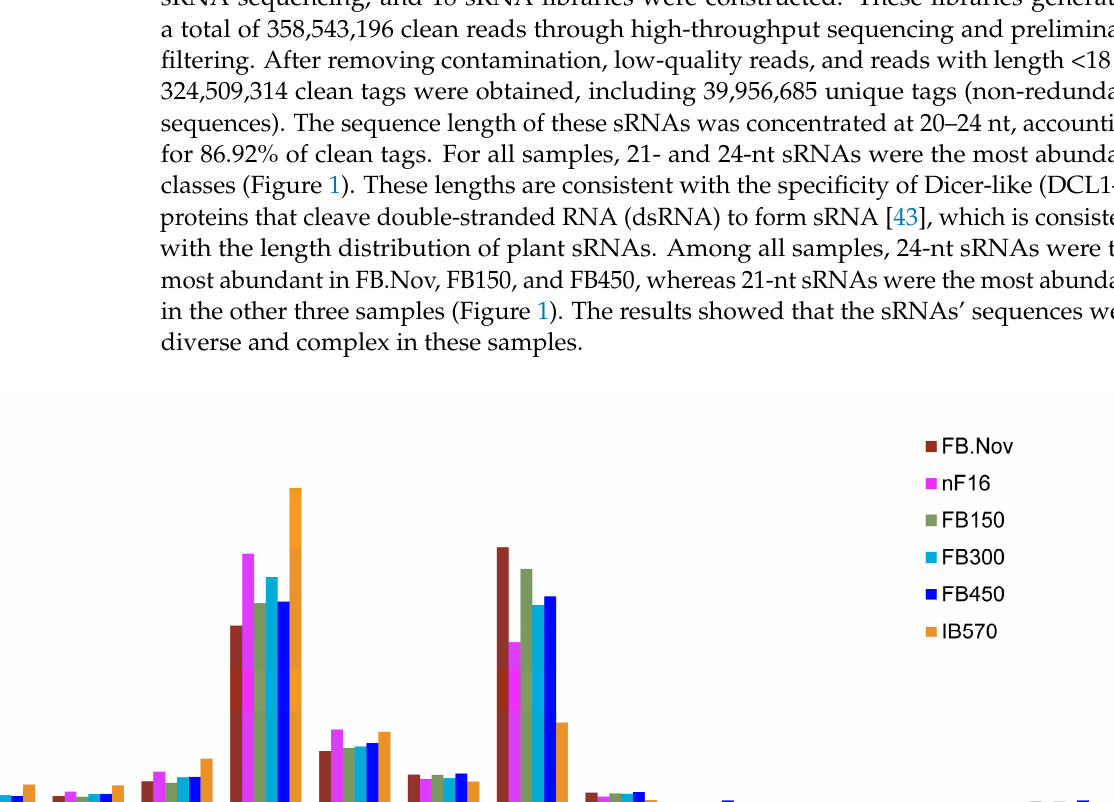
Table 1. Annotation and classification of small RNAs.